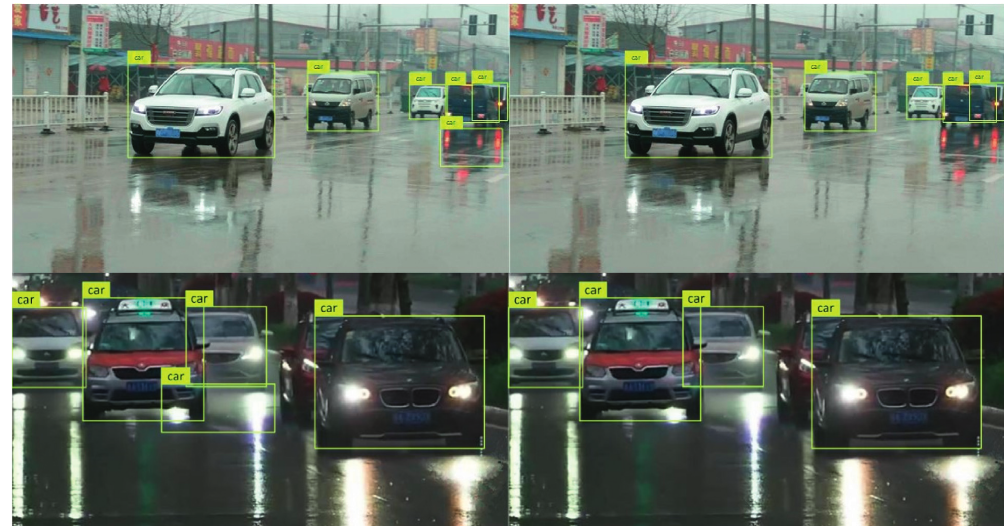
Figure 24: Comparison of detection results of VM and improved VM in an environment with